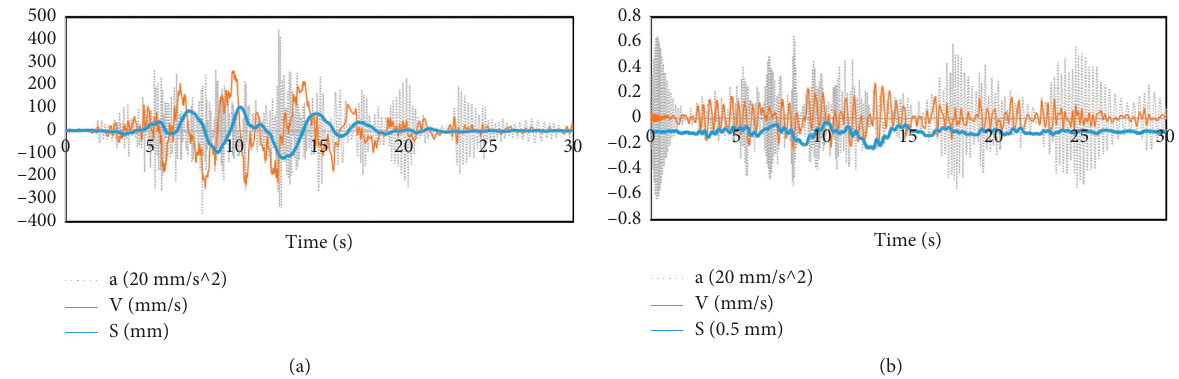
Figure 45: Time course curves of displacement, velocity and acceleration of bearing deformation when REN1 is input from X direction. (a) Horizontal deformation. (b) Vertical deformation.